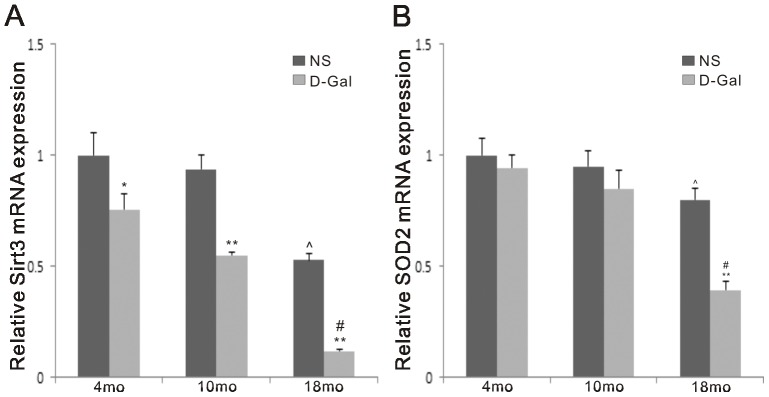
mRNA expression of Sirt3 and SOD2 in the auditory cortex.Quantitative RT-PCR was used to measure the effect of age and D-Gal on Sirt3 and SOD2 mRNA expression. The levels of Sirt3 mRNA expression in the three D-Gal groups were significantly lower than the NS groups, but a significant decrease of SOD2 mRNA expression was only found between the 18-month-old NS and D-Gal groups. Both gene expressions were significantly decreased with age. *Significantly different from the NS groups (*P<0.05, **P<0.01). ∧Significantly different from the 4-month-old NS group (P<0.05). # Significantly different from the 4-month-old D-Gal group (P<0.01). Data are expressed as the mean ± SEM. (n = 6 per subgroup)